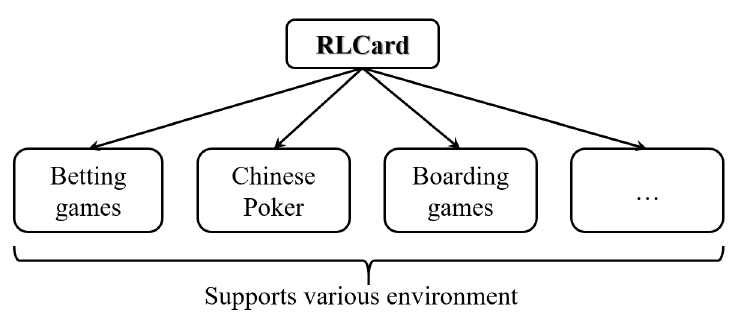
Figure 4. RLCard: It supports various styles of card games and board games [58].